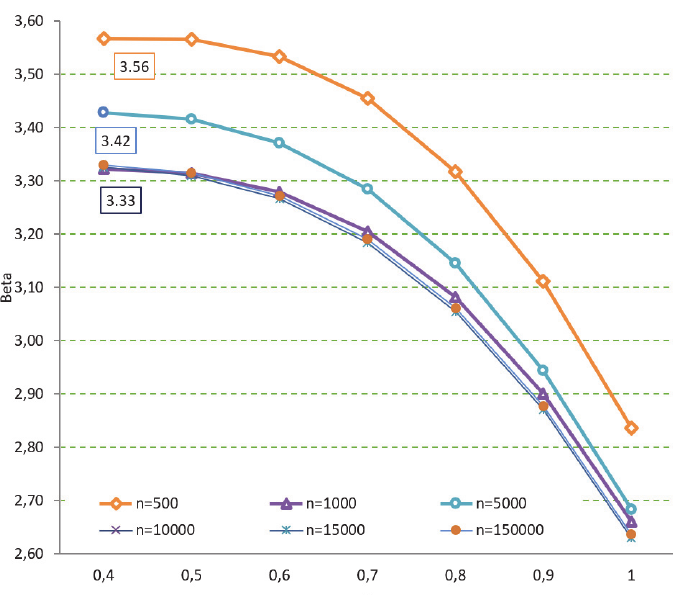
Figure 3: ACI beta index for shear-torsion for different Monte Carlo cycles